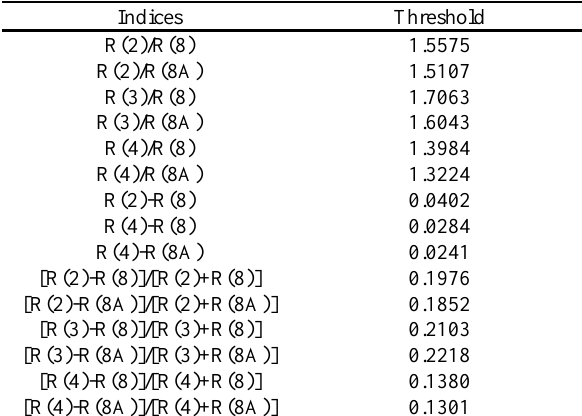
Table 3. Statistical parameters calculated for each index in order to evaluate their ability in HAB detecting